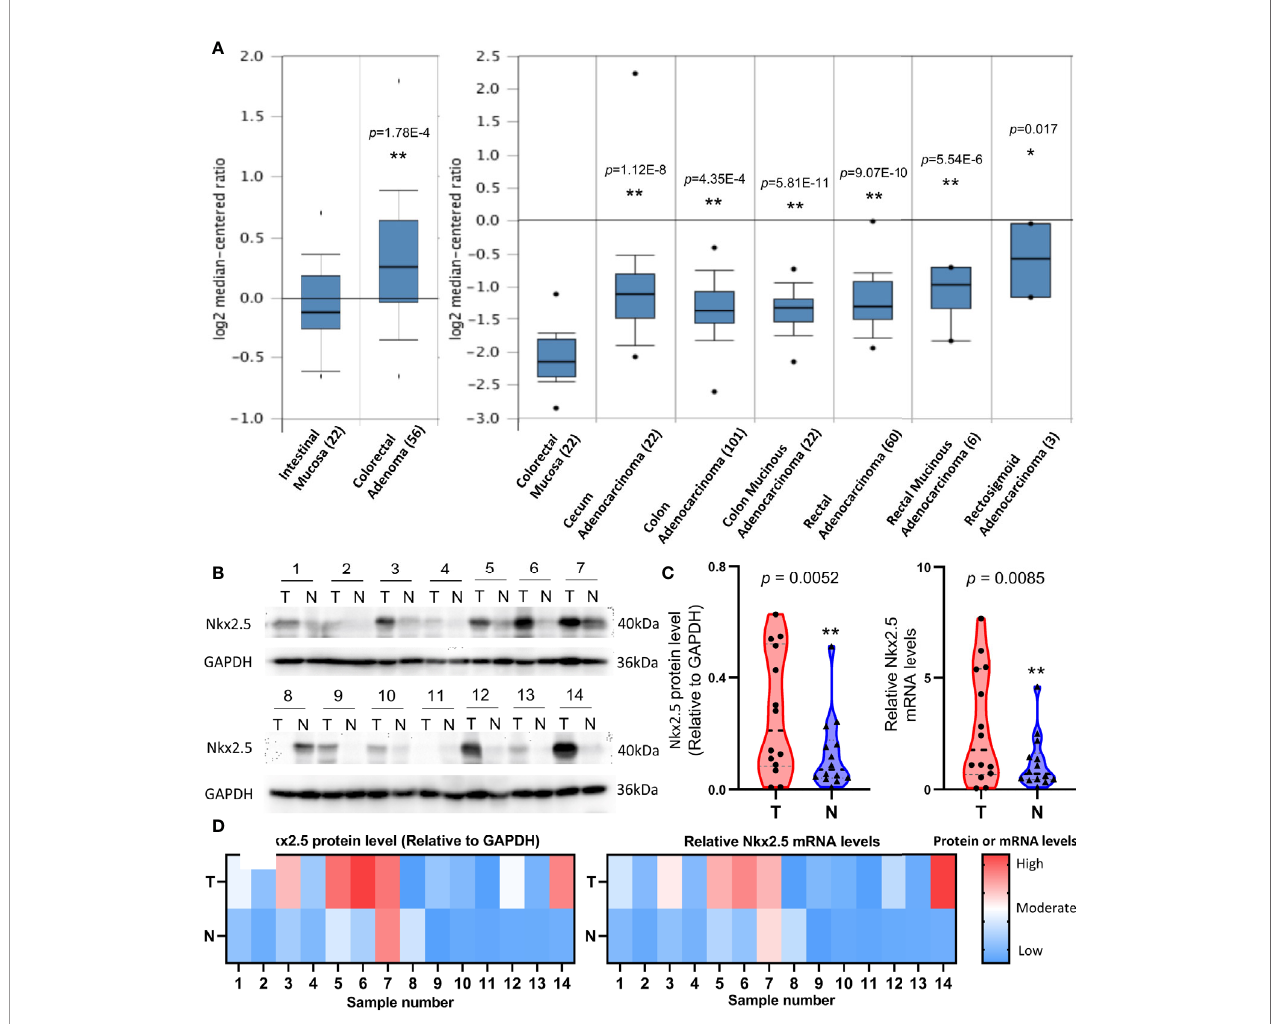
FIGURE 1 | Higher expression level of Nkx2.5 in CRC samples than that in NCM samples. (A) Expression level of Nkx2.5 in colorectal adenomas, CRC, and NCM tissues. The graph was downloaded from ONCOMINE database. The numbers in brackets represent the sample size. (B) Western blot analysis was employed to measure Nkx2.5 protein level in 14 paired CRC and NCM samples. (C) RT-qPCR was used to detect Nkx2.5 mRNA level in CRC and NCM samples. (D) Protein and mRNA levels of Nkx2.5 in 14 paired CRC and NCM samples presented by heat maps. “ T ” represents CRC sample; “ N ” represents NCM sample. * represents P < 0.05; ** represents P < 0.01; ns represents P ≥ 0.05 (no statistical signi fi